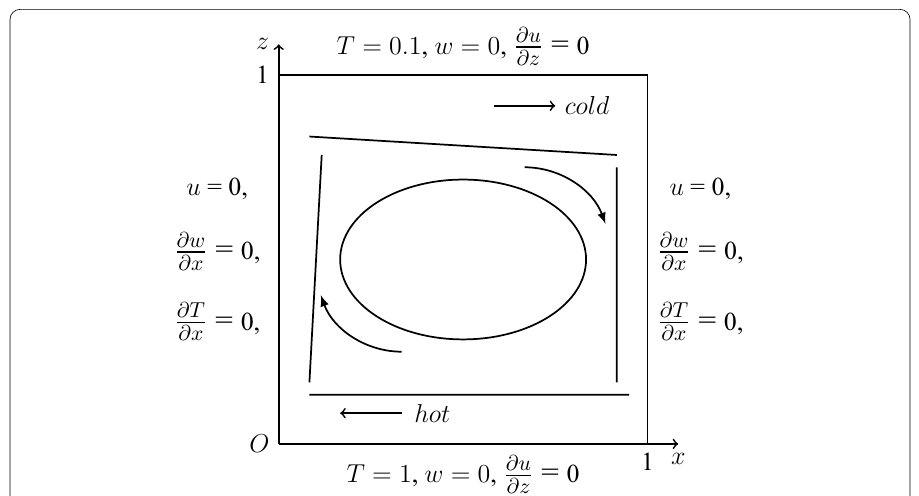
Fig. 1 Schematic diagram of a basally heated non-dimensional unit aspect-ratio cell in